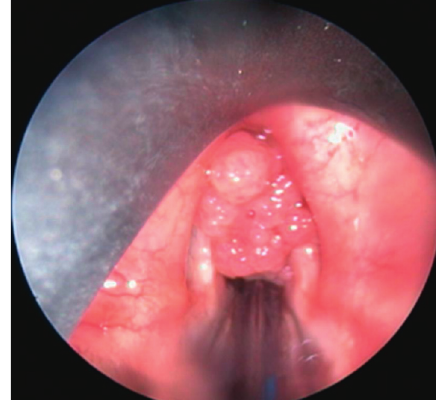
Figure 2: Endoscopic image showing clusters of